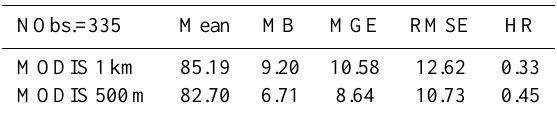
Table 2. Same as Table 1 but for relative humidity. Observed mean relative humidity is 75.98%.